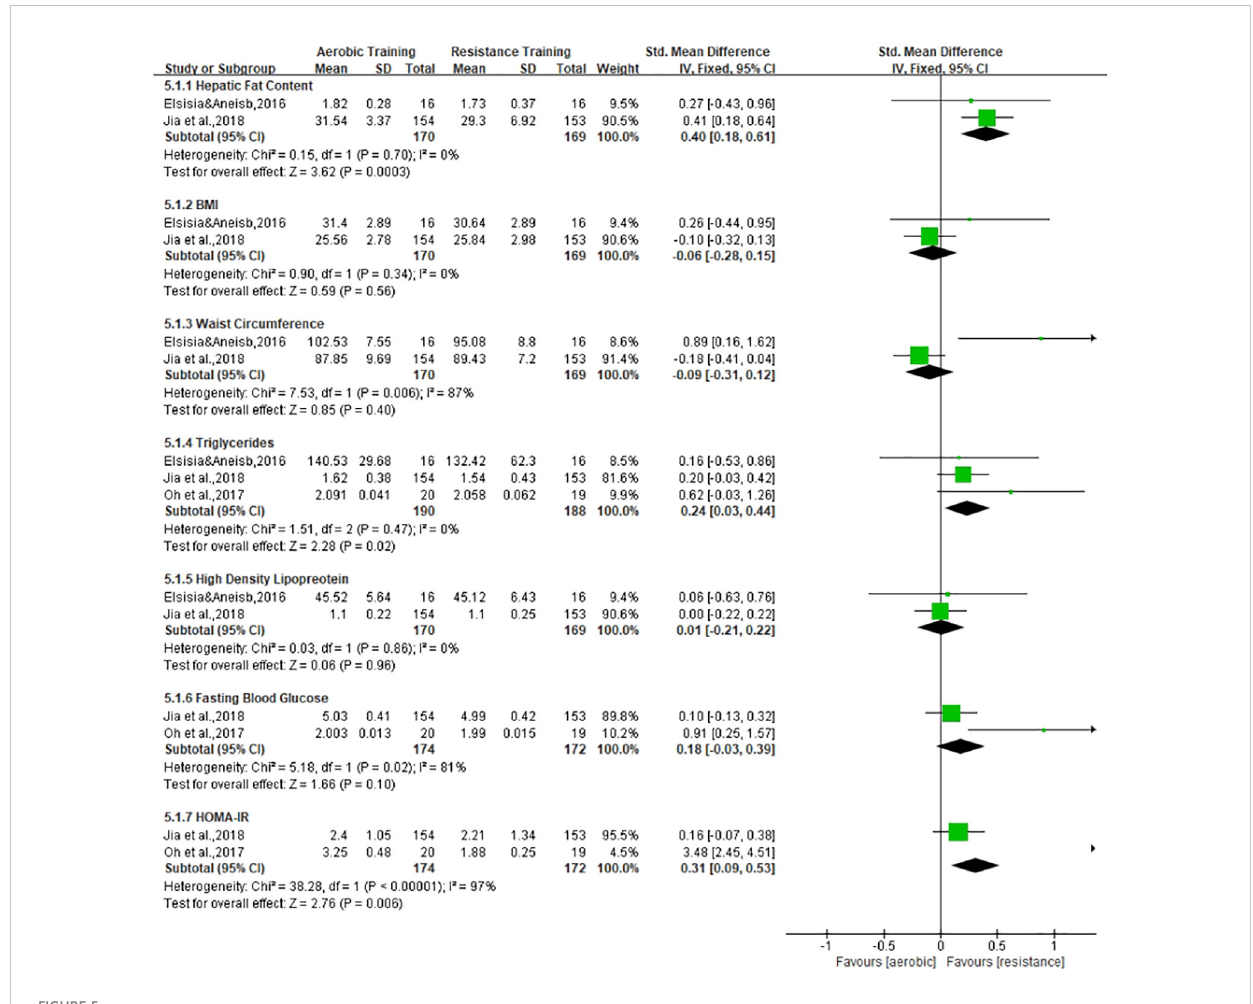
FIGURE 5 Effect of aerobic training vs . resistance training on